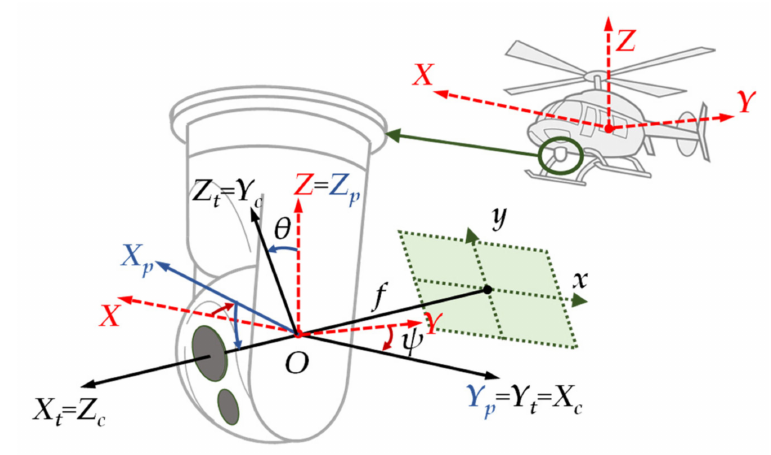
Figure 1. Two-axis gimbal with defined